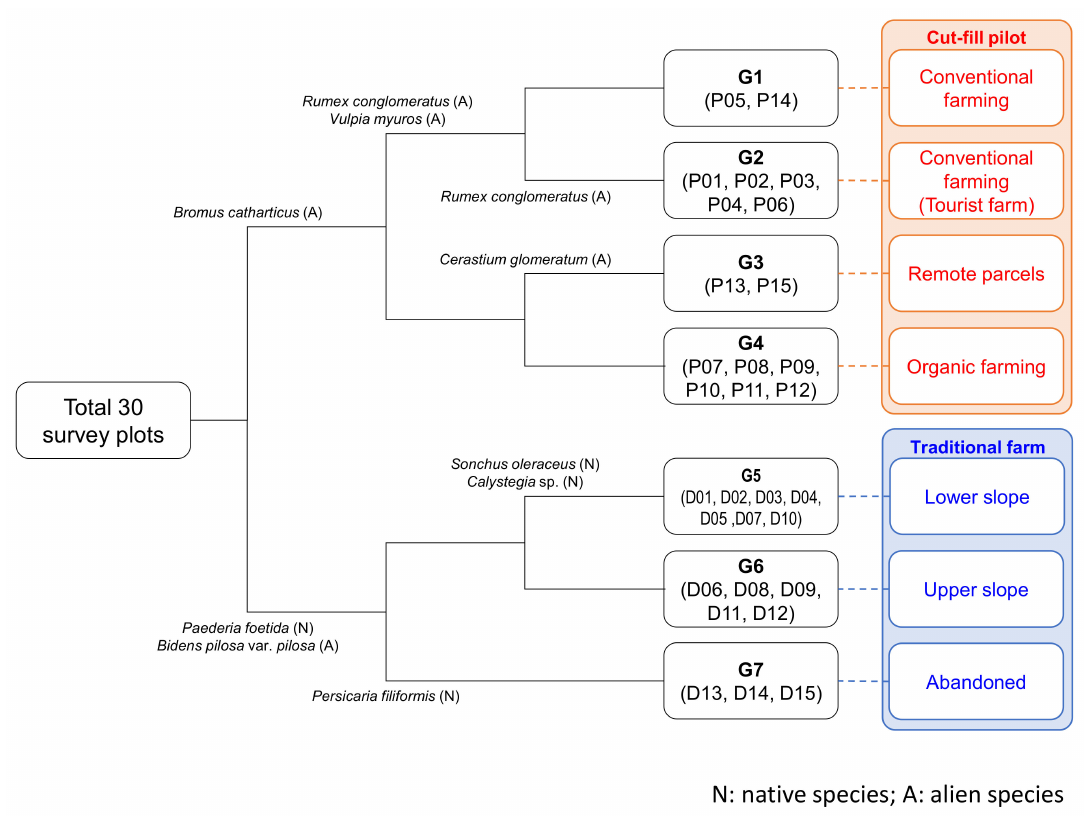
Figure 7. Tree diagram of the TWINSPAN results.